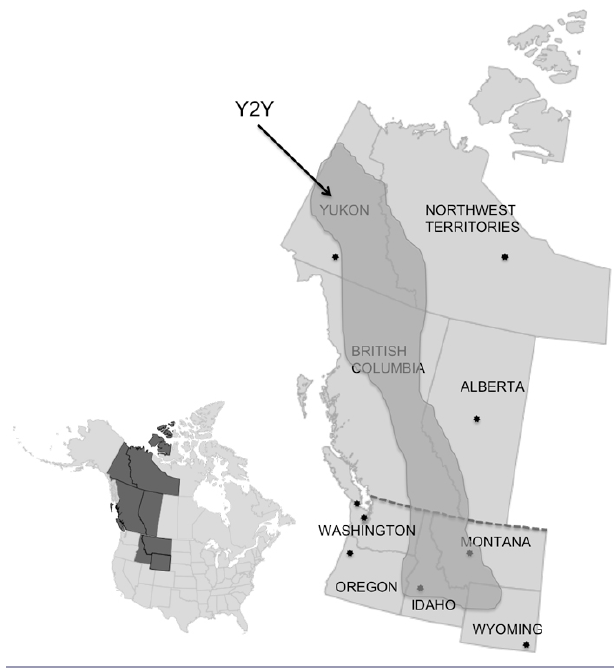
Fig. 2 . Yellowstone to Yukon, crossing the U.S./Canadian border in the northern Rocky Mountains.